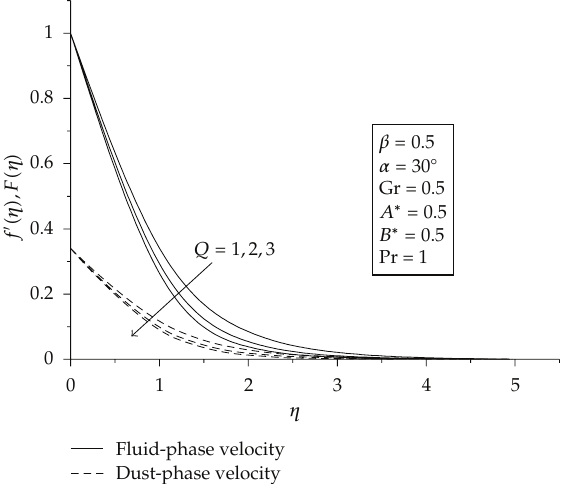
Figure 3: Velocity profile for di ff erent values of Chandrasekhar